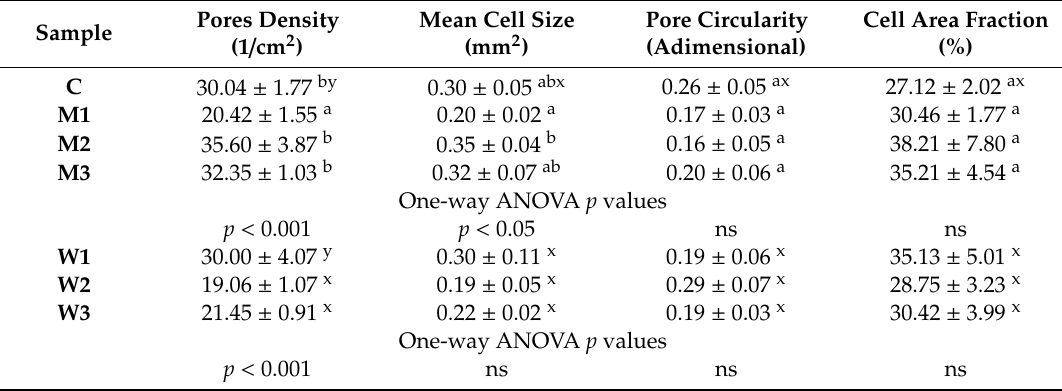
Table 5. Computed bread crumb features.